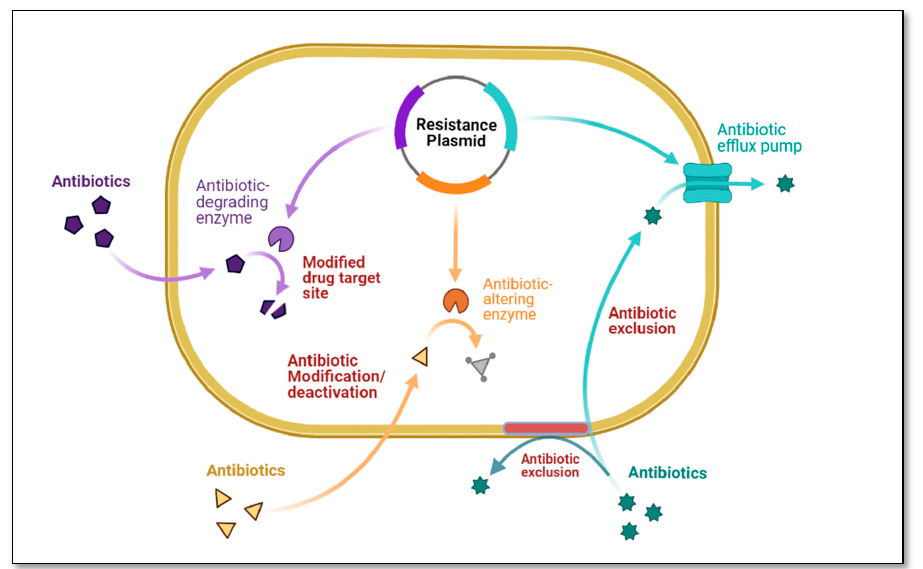
Figure 1. Antibiotic resistance mechanisms (Figure created using Bio-render). Table 3. Different mechanisms of antibiotic resistance with